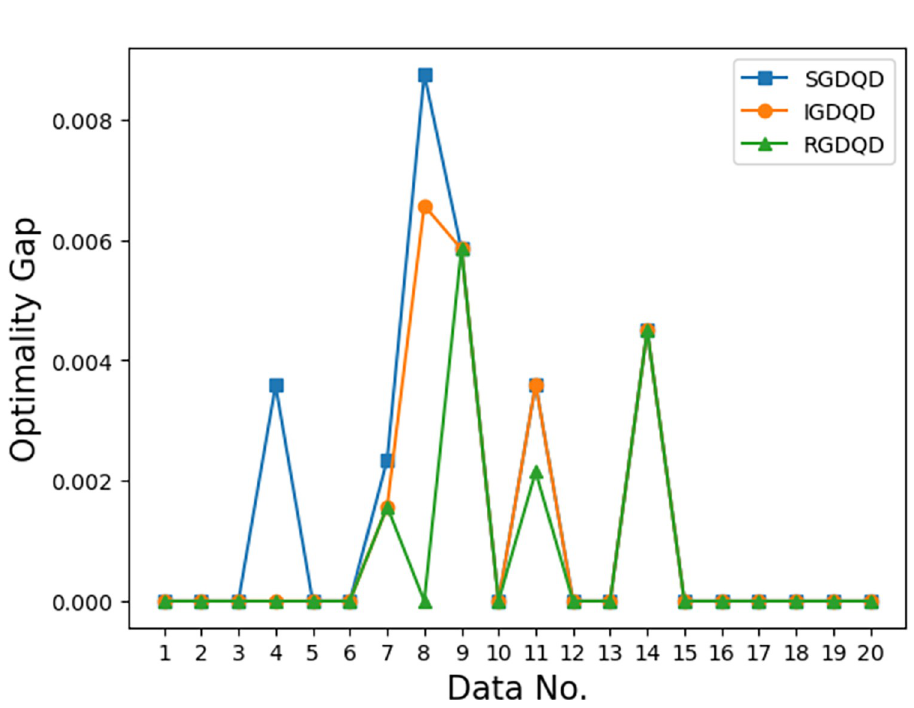
Fig 9. Comparison of optimality gaps for Q = 75000.